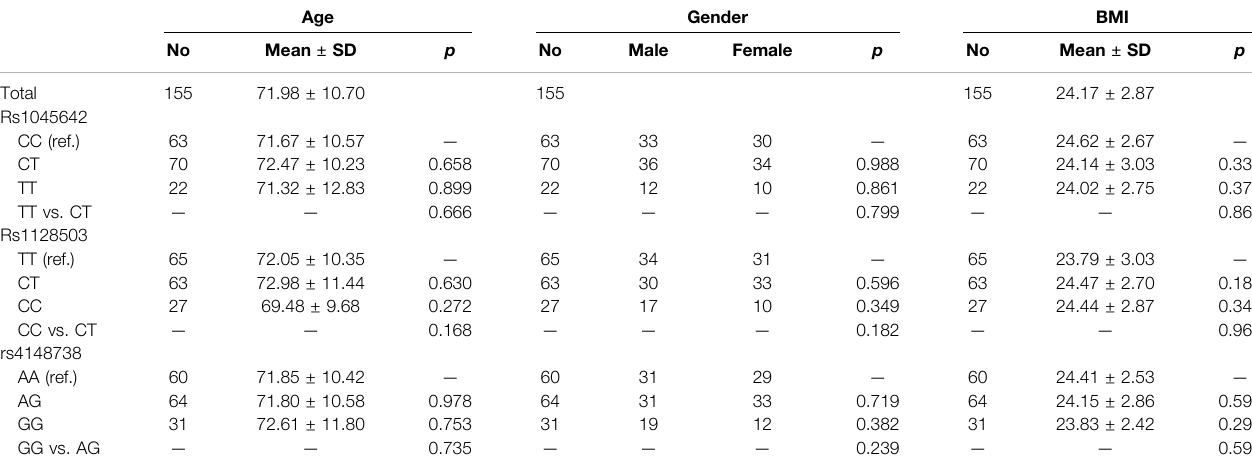
TABLE 6 | Main confounding factors between different SNPs groups.